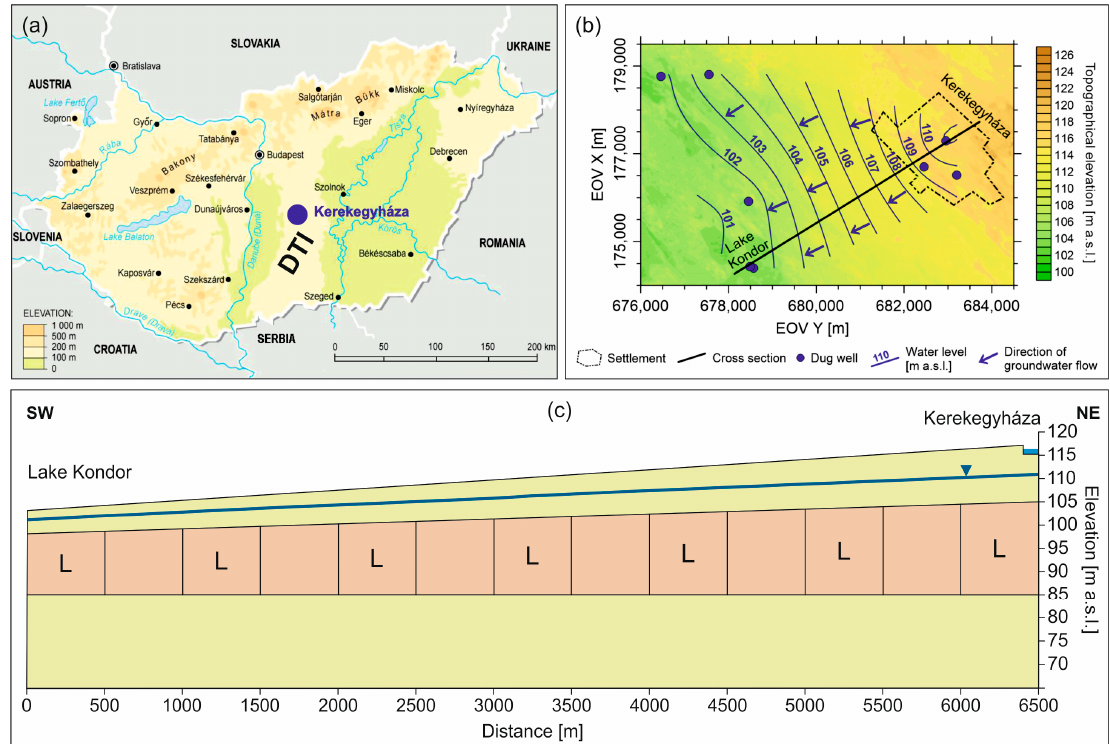
Figure 8. ( a ): Location of the study area in Hungary. ( b ): Location of Kerekegyháza, Lake Kondor and the line of the simulated cross-section. ( c ): Model geometry indicating the location of the middle layer and lenses marked by “L”. The vertical exaggeration is 1:30. Note: The map of Figure 8b uses the Hungarian EOV grid (Uniform National Projection) in which EOV X represents northing and EOV Y represents easting in meters. The topographical data were acquired from the Lechner Knowledge Centre with a resolution of 5 m. The topographical elevation is referenced to the Baltic Sea level. The water level contour map was constructed by the Kriging method based on field measurements in dug wells indicated on the map (time of measurement: 16 September 2020).